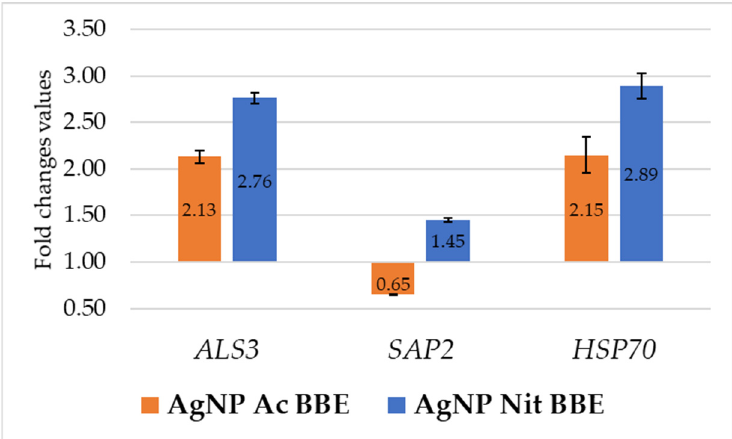
Figure 4. The influence of AgNP BBEs on C. albicans gene expression for ALS3 , SAP2 , and HSP70